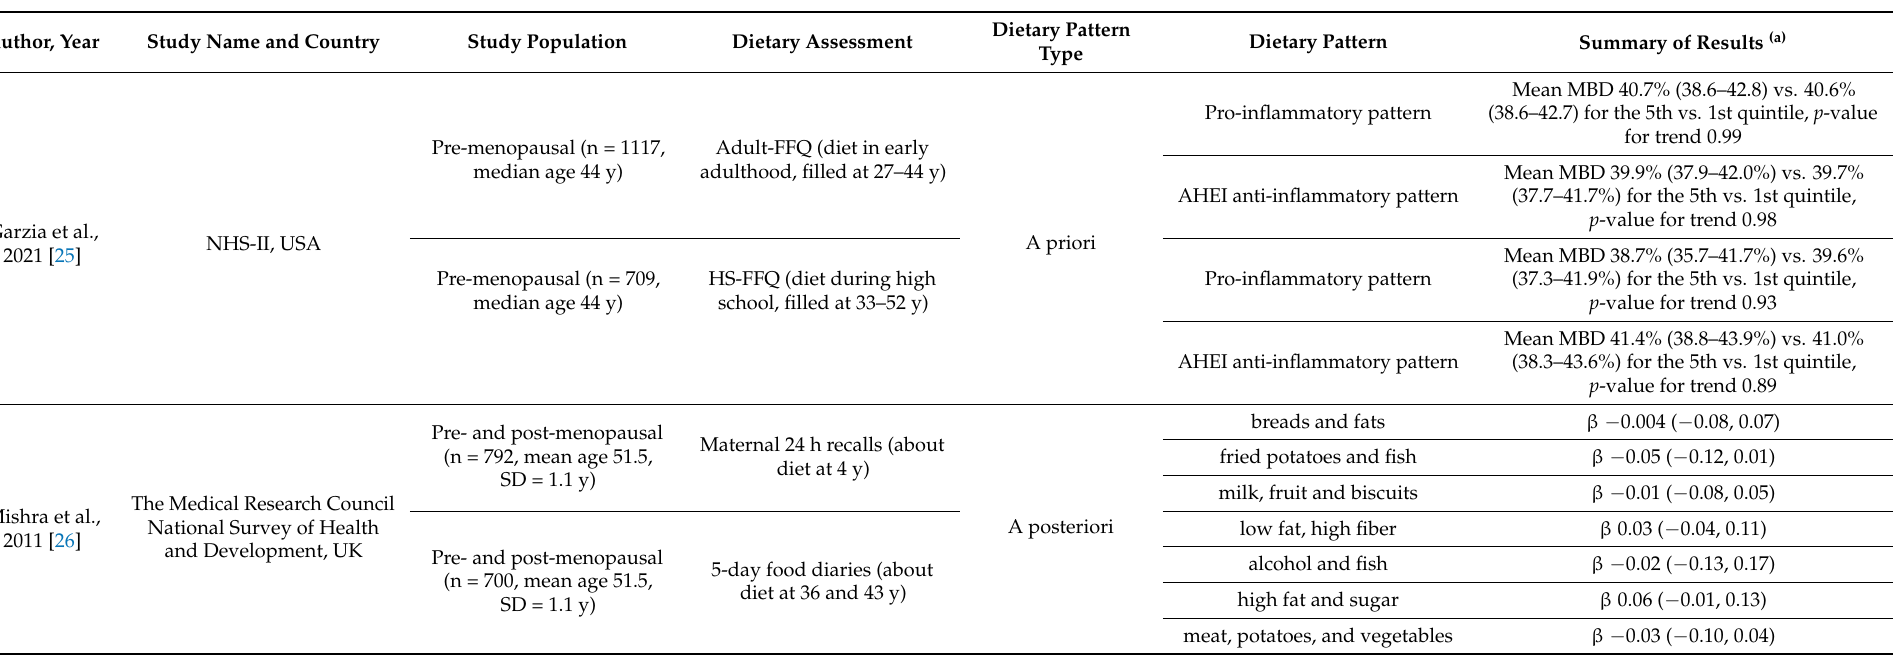
Table 2. Main characteristics and results (for the whole study group, or stratified by menopausal status when available) of cohort studies reporting on the association between a-priori- or a-posteriori-defined dietary patterns and mammographic breast